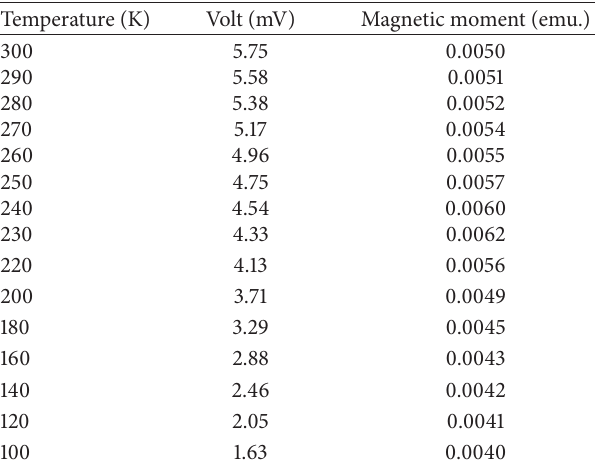
Figure 2: (a) Morin transition curve for synthesized iron oxide nanoparticles. (b) VSM studies of synthesized iron oxide. Table 2: Magnetic susceptibility data of iron oxide.